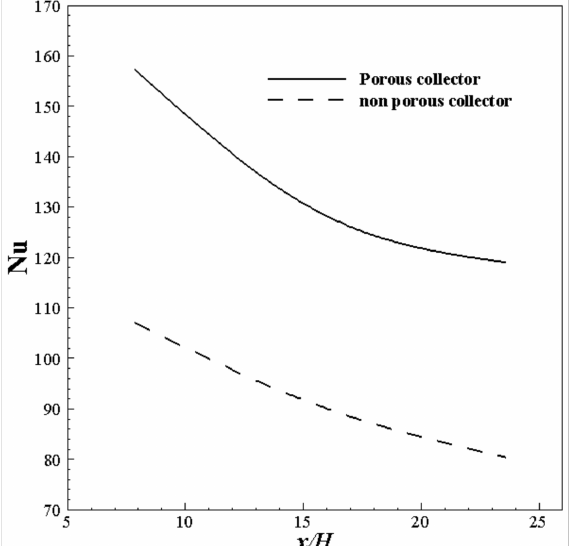
Figure 5. The variation in the Nusselt number versus the length to height ratio into porous and non-porous collectors at u in = 0.5 m/s, T in = 298, ε = 0.8, and K = 6 × 10 − 10 m